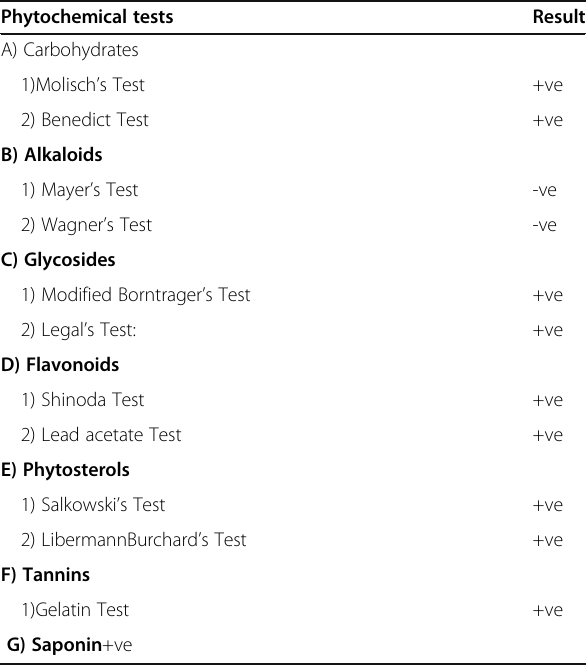
Table 1 Results of phytochemical screening of Methanolic Extract of Luffa cylindrica (L . )